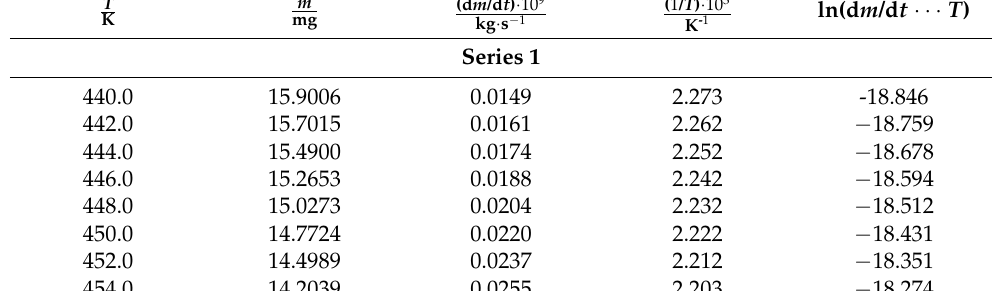
Table 5. Thermogravimetric data of an experimental series and the vaporization enthalpy of 1MH. T K